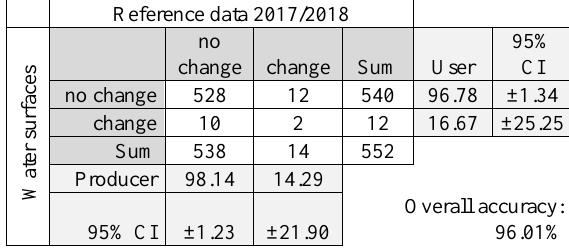
Table 7 . Confusion matrix for change layer Water